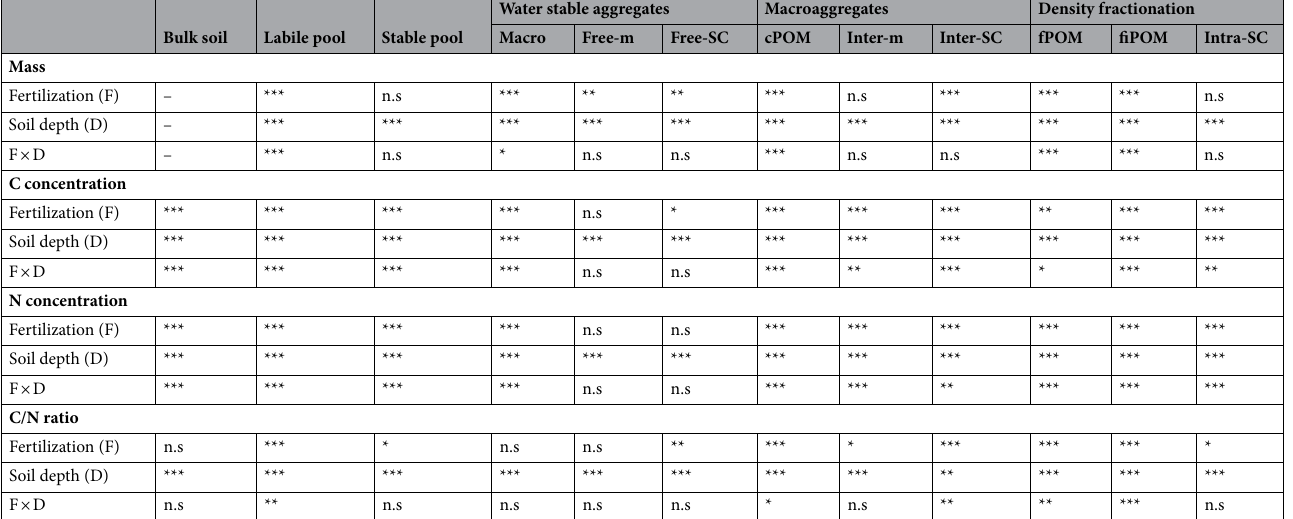
Table 2. Analysis of variance results for the effects of the fertilization practices, soil depth, and their interactions on the mass, C concentration, N concentration, and C/N ratio in bulk soil and aggregates of different sizes. Macro macroaggregates, Free-m free macroaggregates, Free-SC free silt–clay particles, cPOM coarse particulate organic matter, inter-m microaggregates within macroaggregates, Inter-SC silt–clay particles in macroaggregates, fPOM fine particulate organic matter, fiPOM fine intra particulate organic matter, Intra-SC silt–clay in inter-m. *Indicates that a difference was found by performing the ANOVA at P < 0.05, ** indicates that a difference was found by performing the ANOVA at P < 0.01, *** indicates that a difference was found by performing the ANOVA at P < 0.001, n.s. indicates that no significant difference was found by performing the ANOVA at P >